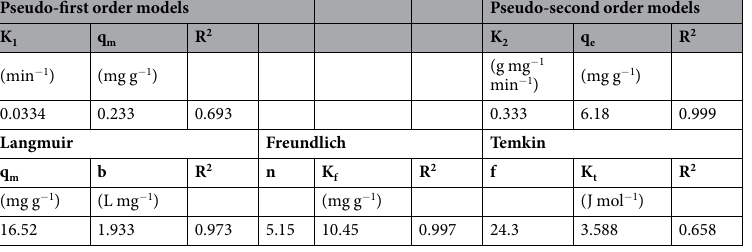
Table 1. Kinetics and isotherm models parameters for Cu 2 + adsorption on PS@Fe 3 O 4